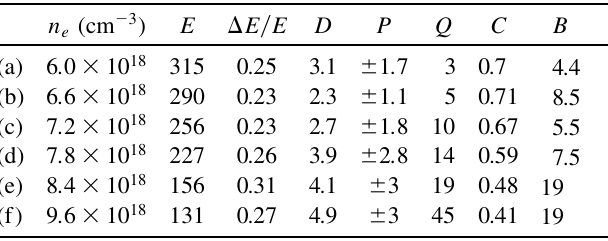
TABLE I. Electron-beam characteristics for the parameters of Fig. 4 averaged over 10–20 shots. n e is the electron density, E is the central energy in MeV, (cid:1) E=E is the normalized energy spread (FWHM), D is the FWHM divergence in mrad, P is the pointing stability in mrad, Q is the average integrated charge in pC, C is the contrast defined as the ratio of beam charge within FWHM in energy to the total beam charge, and B is the bright- ness per shot in units of 10 10 electrons MeV (cid:3) 1 mm (cid:3) 2 mrad (cid:3) 2 . In every series of shots, the measured fluctuation in the total charge is (cid:1) 50%